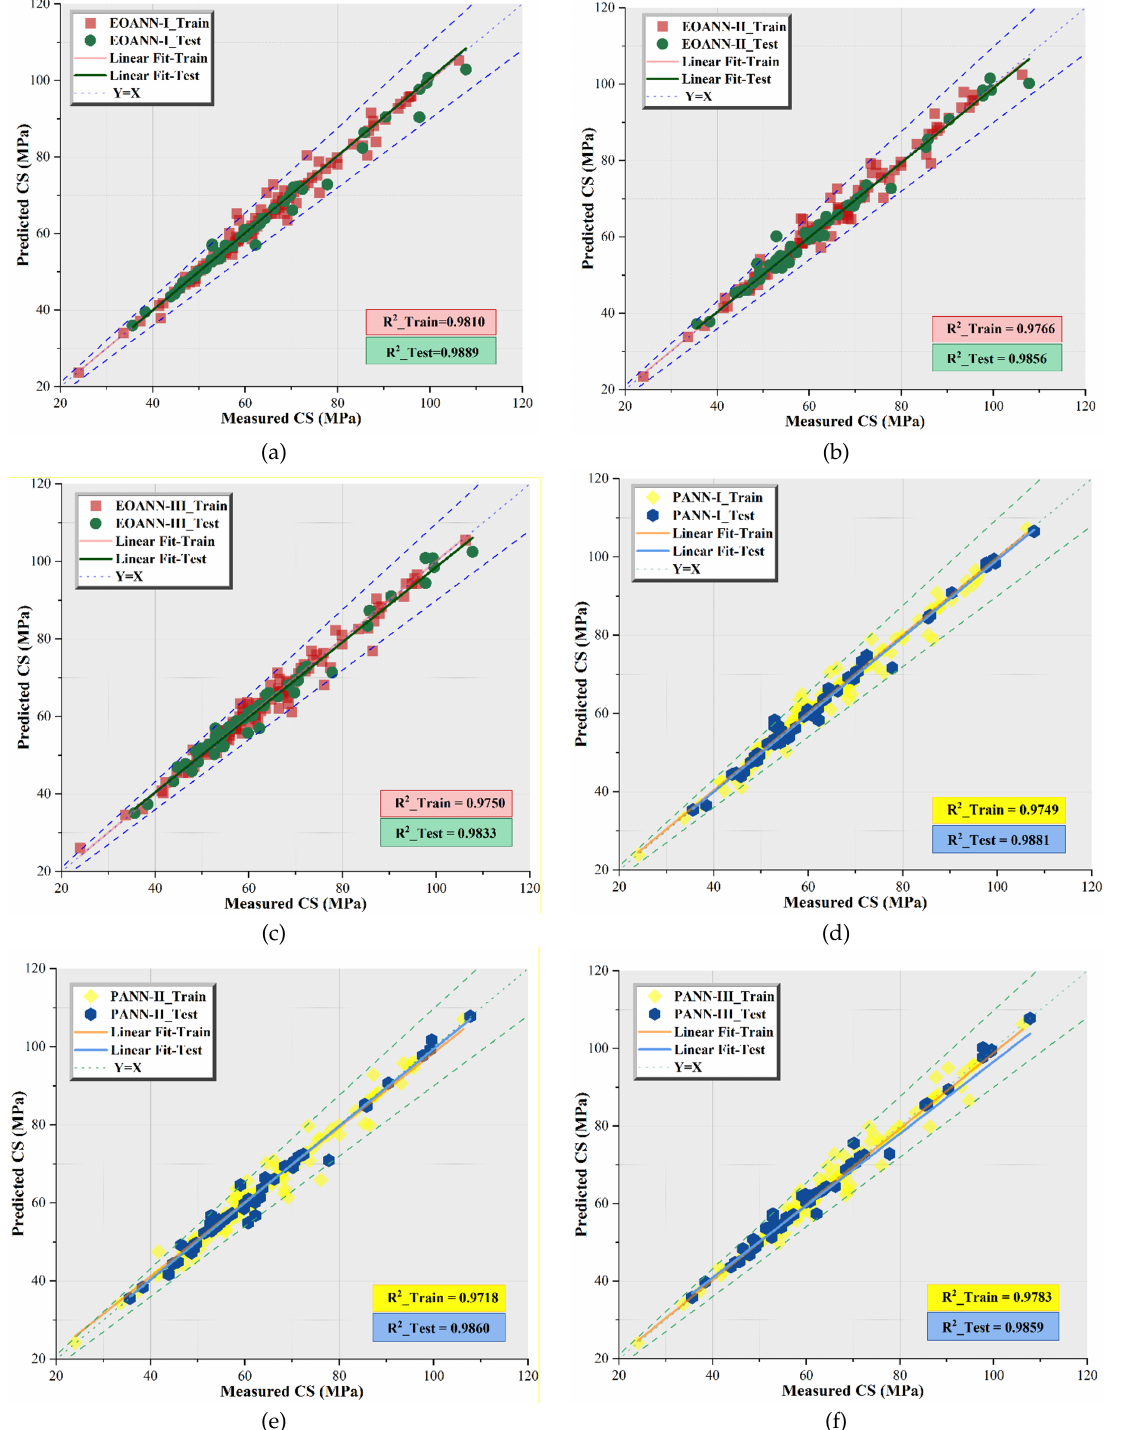
Fig. 5. The scatter plot of developed hybrid models for the train and the test phases: a) EOANN-I b) EOANN -II c) EOANN -III d) PANN-I e) PANN –II f) PANN -III ficulties. For this purpose, two hybrids artificial neural sive strength for the HPC concrete. The summary of the network-based models were developed to predict compres- results is concluded as